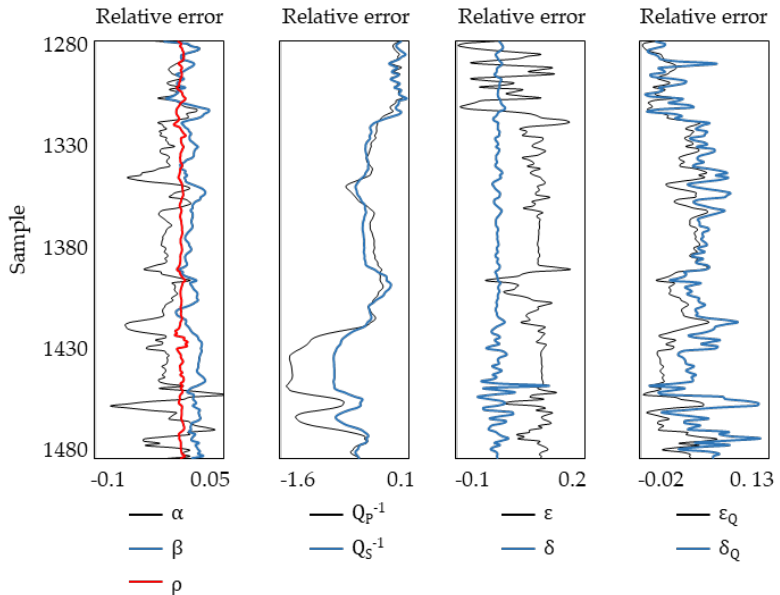
Figure 11. The relative errors between inverted result and model value of each parameter.